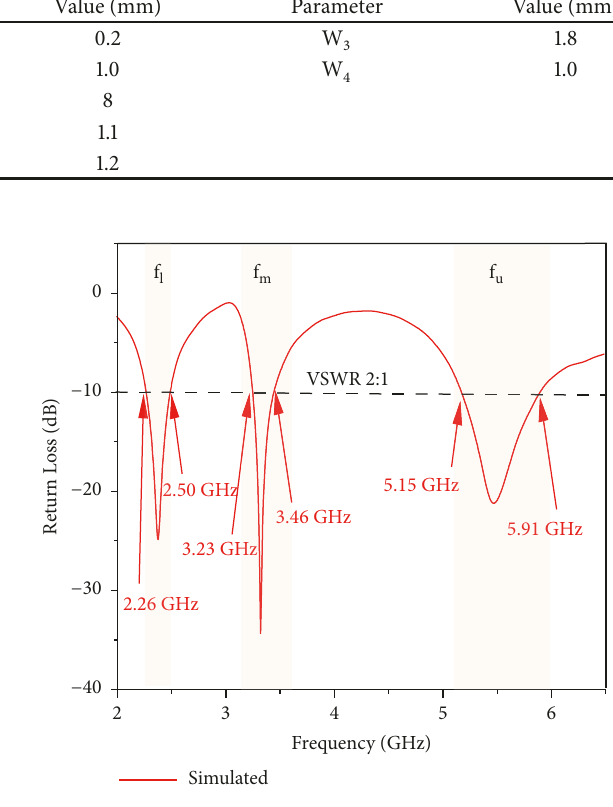
Figure 6: Simulated return loss of proposed antenna mounted on the system ground (supporting 13 󸀠󸀠 laptop display